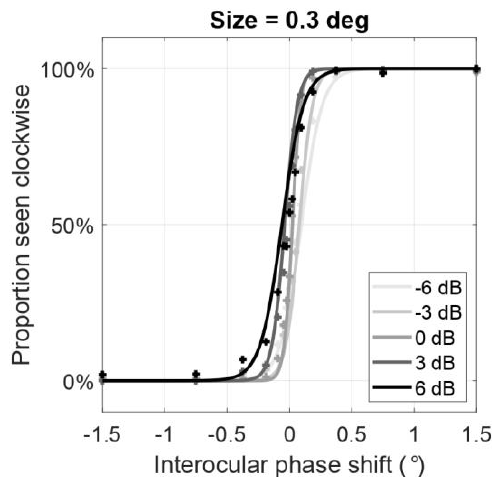
Figure 4. Averaged psychometric functions of the perceived rotation direction as a function of the interocular phase shift between the eyes from all observers when the size of the Gabor elements was maintained at 0.3 deg in both eyes. Each shade of grey represents different ratios between the spatial frequencies of the Gabor elements shown to left and right eye (LE/RE) from −6 dB (light grey) to 6 dB (dark grey), where 0 dB represents a linear ratio of one (same spatial frequency in the two eyes images). Datapoints were fitted by a logistic function. Interocular phase shift (indicated by x -axis) where the proportion seen clockwise is 50% (indicated by y -axis) indicates where the rotation of the cylinder is ambiguously clockwise or counterclockwise to the observer. Throughout this paper, we refer to this region as the point of subjective equality (PSE). The PSE decreases as the ratio dB between the spatial frequencies in the two eyes increases.